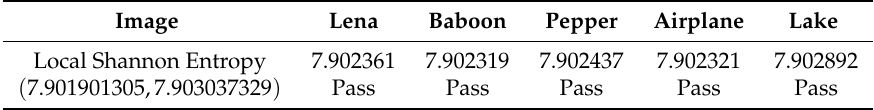
Table 10. The local Shannon entropy